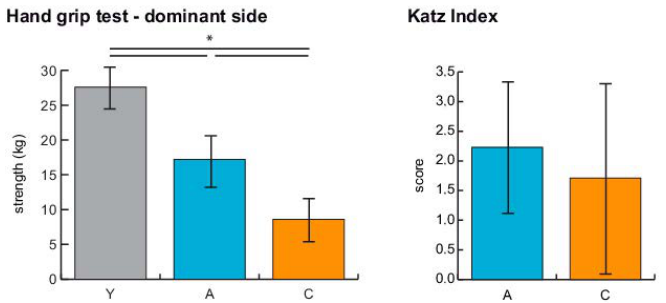
Figure 1. Histograms showing the mean (± SD) maximum hand grip strength (kg) and the Katz Index scores observed among the young (Y), aged (A), and centenarian (C) female subjects enrolled in this study (* = significant difference, ANOVA and Tukey, p -value < 0.05).